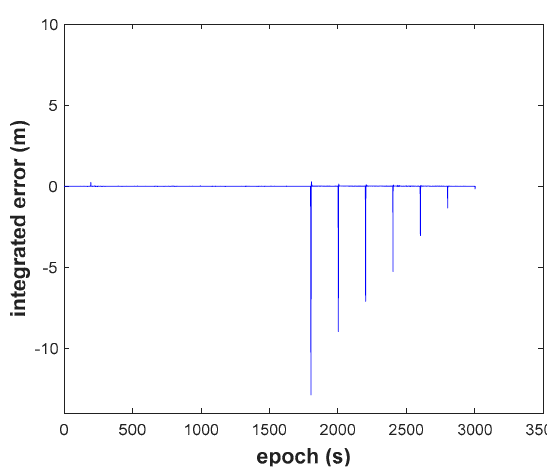
Figure 14. Height position errors of EKF.